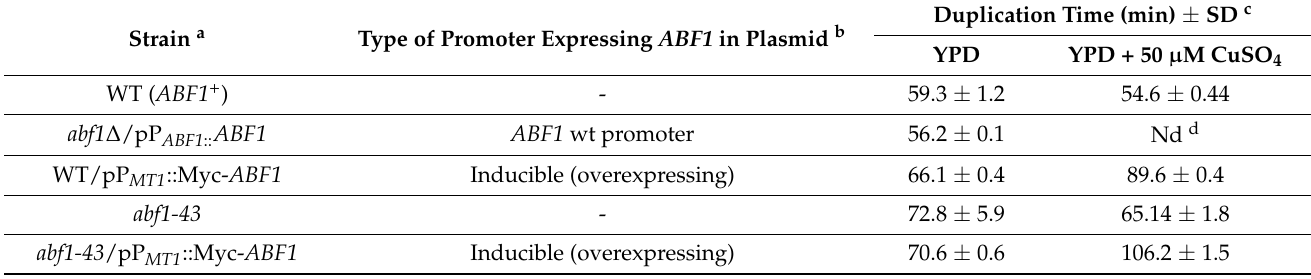
Table 1. Duplication time of strains overexpressing c-Myc- ABF1 (pP MT1 ::c-Myc- ABF1